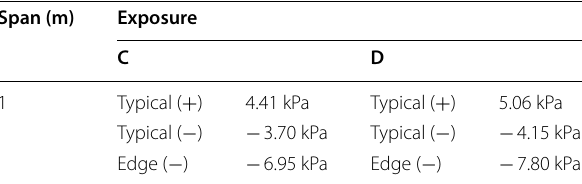
Table 2 Comparison of design wind pressure between Seoul and Busan, (b) Busan (importance factor 1.0/height of a building 199 m/height of a floor 4.5 m).